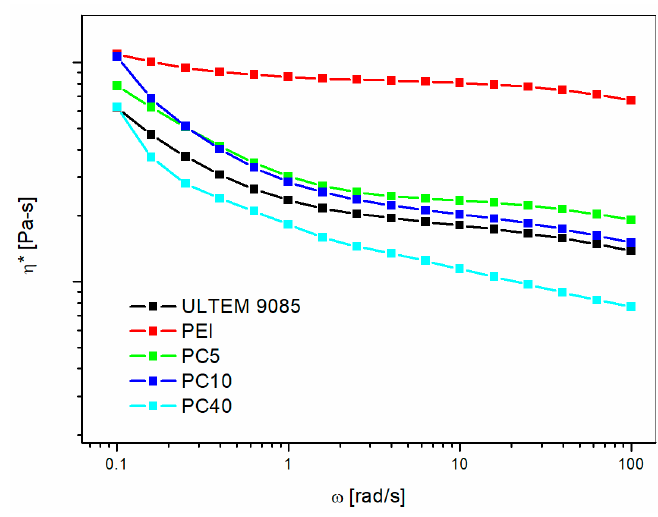
Figure 2. Isothermal rheology at 350 °C for PEI/PC blends with different content of PC.